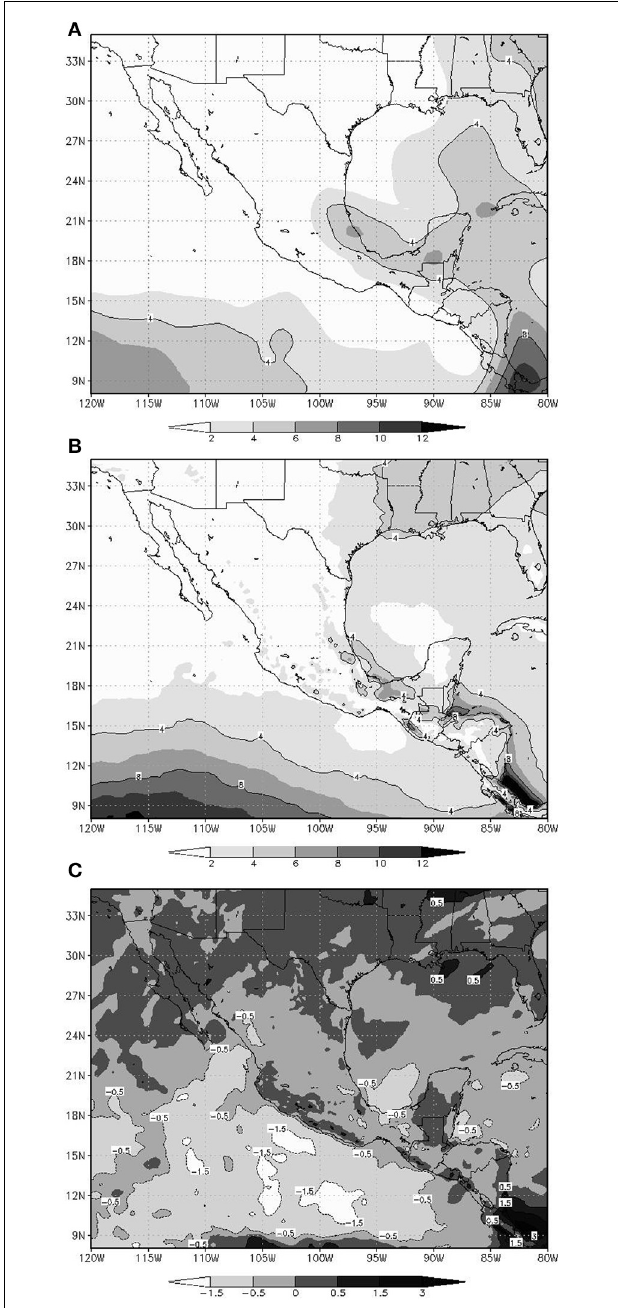
FIGURE 2 | Mean NH winter precipitation (mm day − 1 ). (A) Obtained from the NCEP/NCAR reanalysis for the 1980-1988 period, (B) as in (A) , but obtained with the TL959L60 AGC model for the 1980–1989 period, and (C) Change in NH winter precipitation (mm day − 1 ) for the 2080–2088, relative to 1980–1989 simulated with the TL959L60 AGC